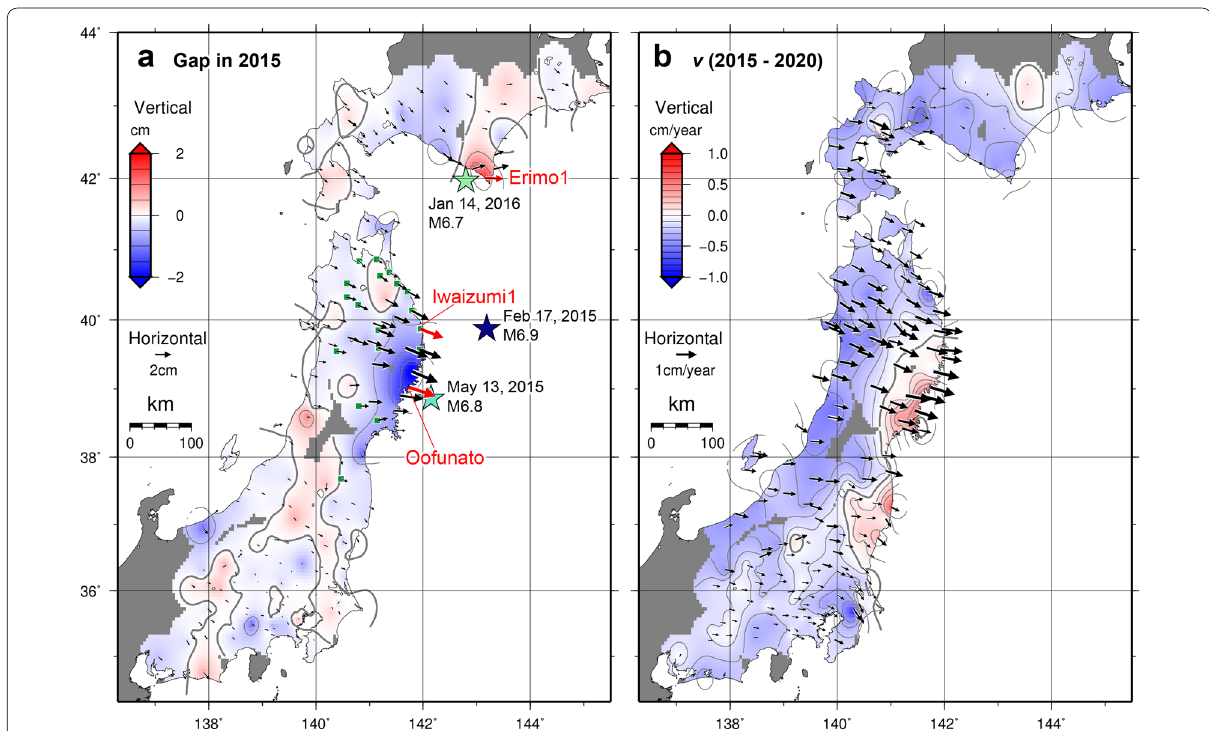
Fig. 5 Distribution of gaps in 2015 and linear deformation fluctuations from 2015 to 2020. a Distribution of gap 2015 . Observation stations denoted in red text are described in Fig. 4. Green squares represent the 18 stacking stations used in Fig. 4d. Stars are epicenters of aftershocks that affected the time series depicted in Fig. 4. b Velocity distribution of linear deformation v from 2015 to